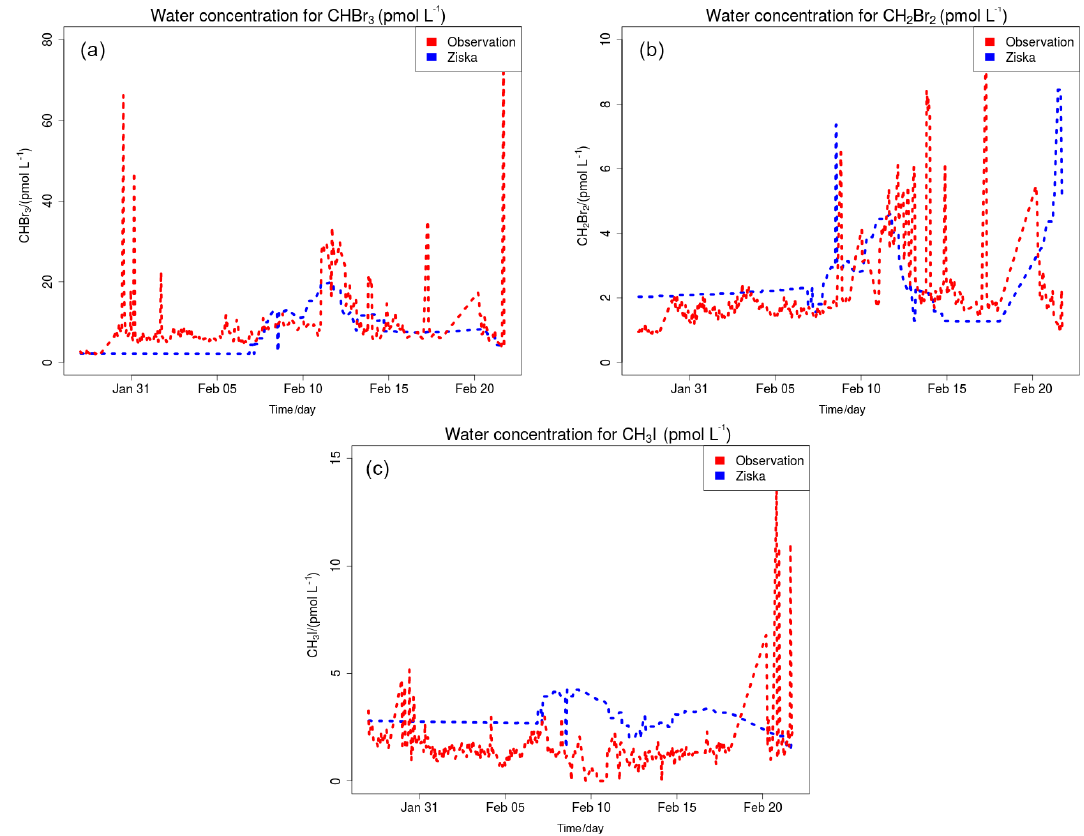
Figure 6. Time series of measured CHBr 3 (a) , CH 2 Br 2 (b) and CH 3 I (c) water concentration (in pmolL − 1 ) during the TORERO campaign (red dashed line) and from the Ziska et al. (2013) climatology (blue dashed